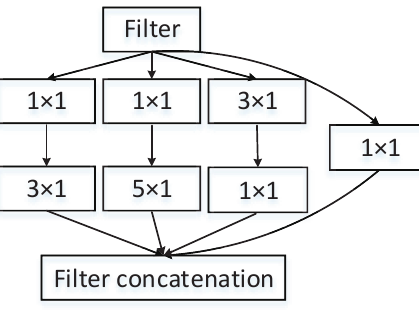
Figure 4. Multi-scale